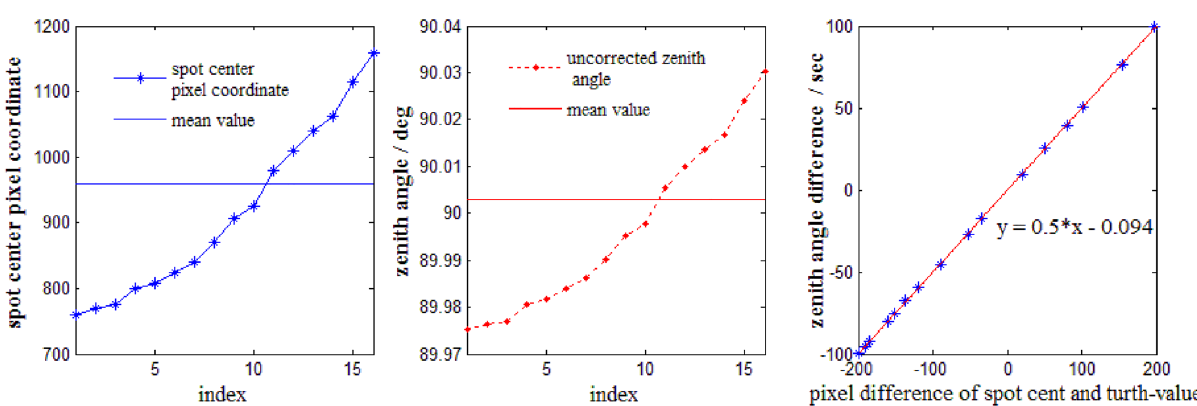
Figure 10. Test of LED recognition and aiming by Leica TM50 I image-assisted total station at 1